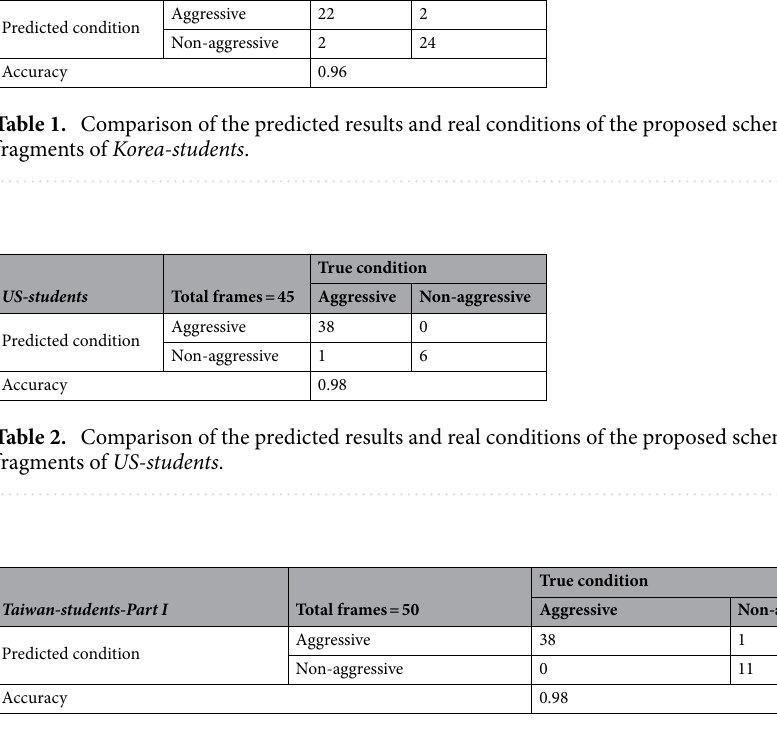
Table 3. Comparison of the predicted results and real conditions of the proposed scheme with the test fragments of Taiwan-students-Part I .